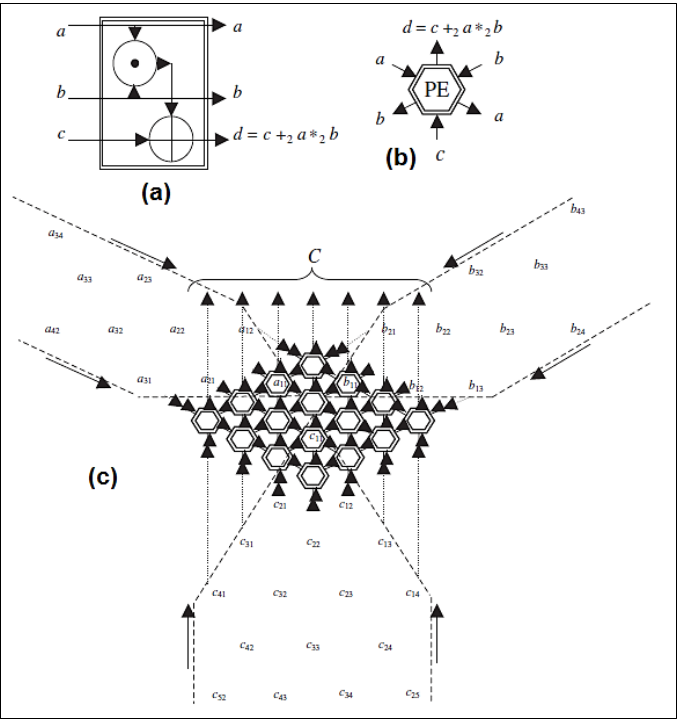
Figure 8. (a) Inner Toffoli gate design, (b) Outer Toffoli gate design, (c) reversible systolic